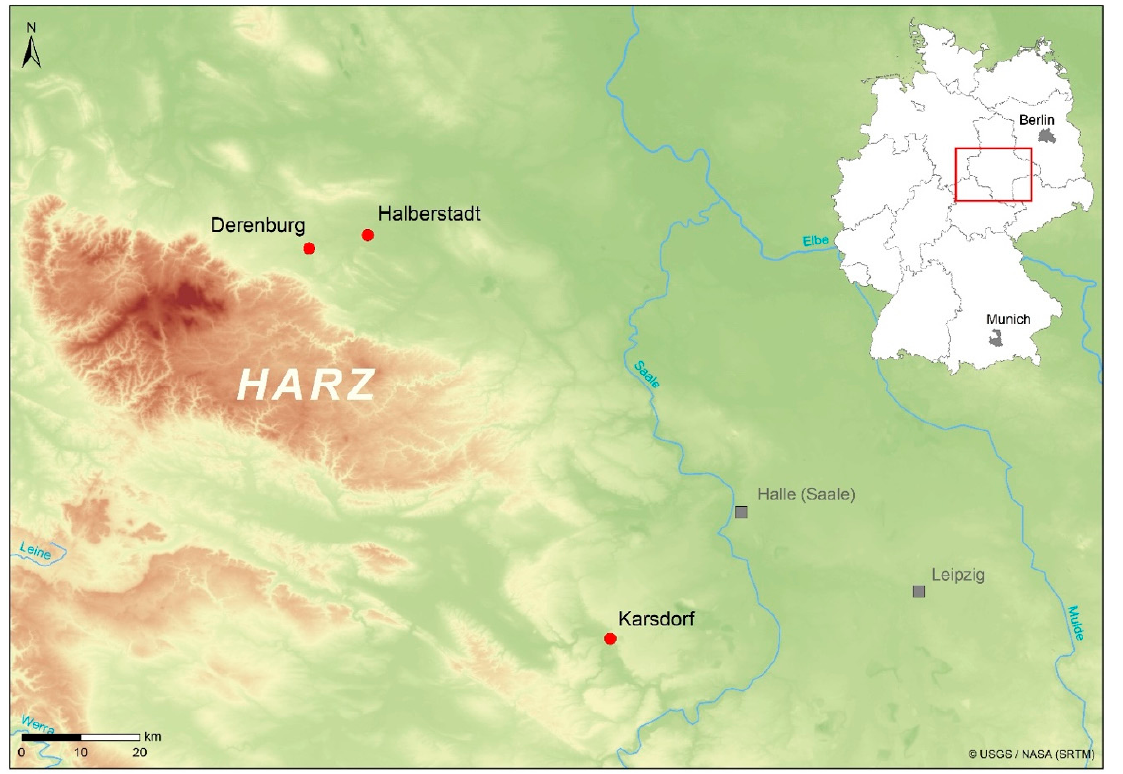
Figure 1. Location of the three sites in the Middle Elbe-Saale region, Saxony-Anhalt, central Germany (LDA, Halle/Saale).